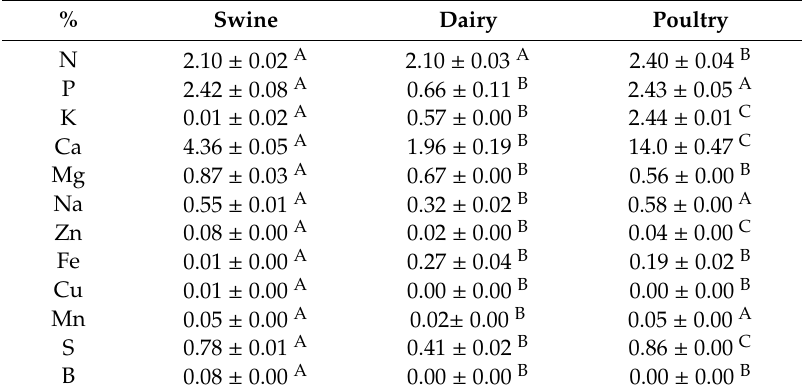
Table 1. Chemical composition (mean ± SE) of swine, dairy, and poultry manure for the black soldier fly